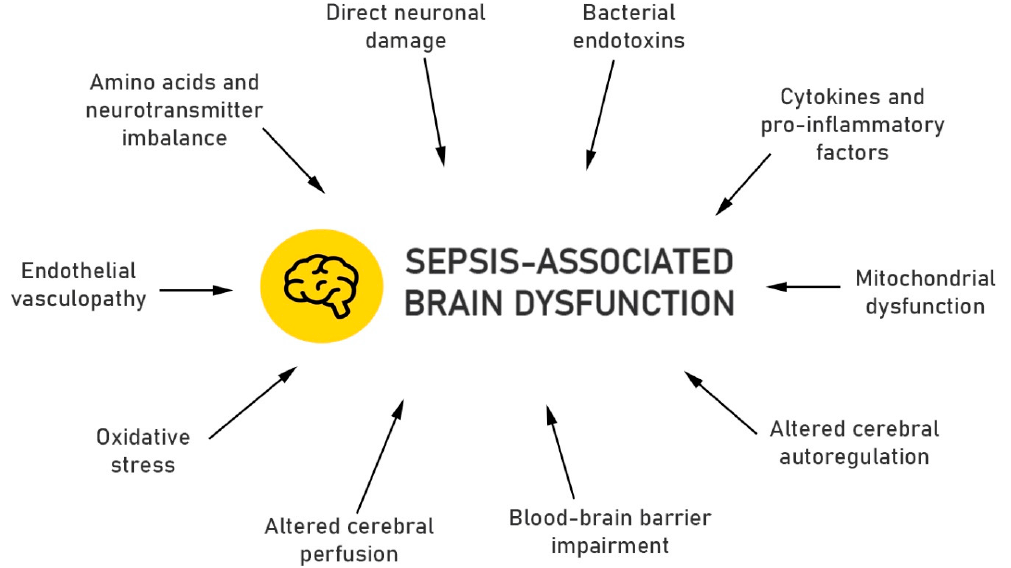
Figure 1. Proposed pathophysiologic changes in sepsis-associated brain dysfunction.